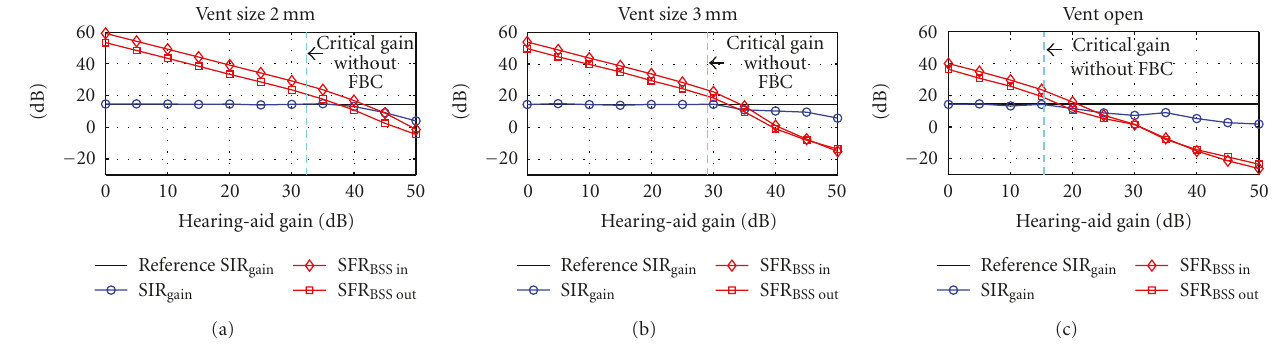
Figure 5: BSS performance for increasing HA gain, in a low-reverberation